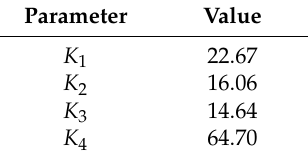
Table 2. Linkage gains.